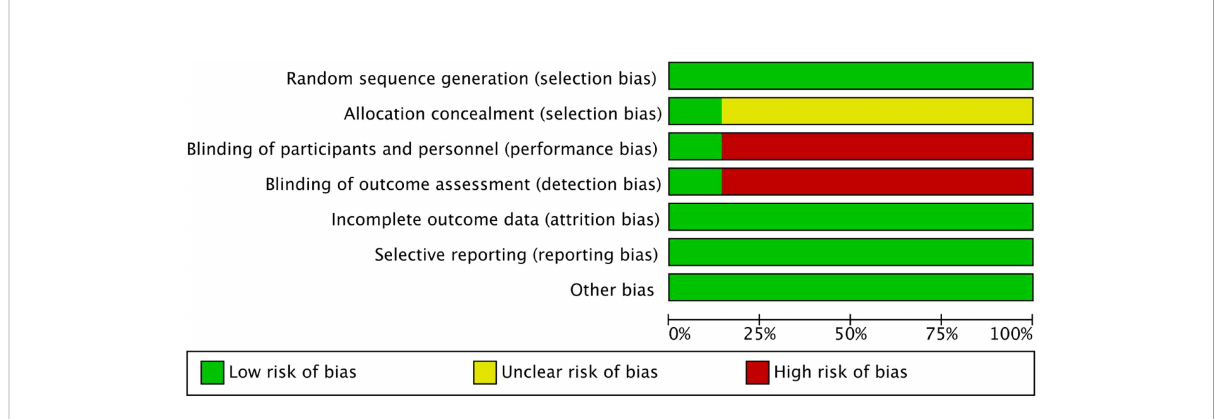
FIGURE 2 Risk of bias graph for seven randomized controlled trials